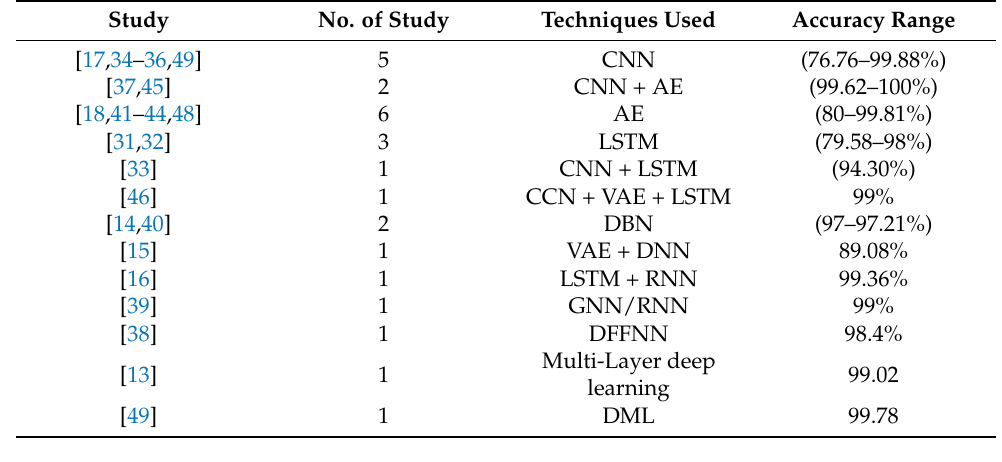
Table 4. Accuracy range for the techniques.